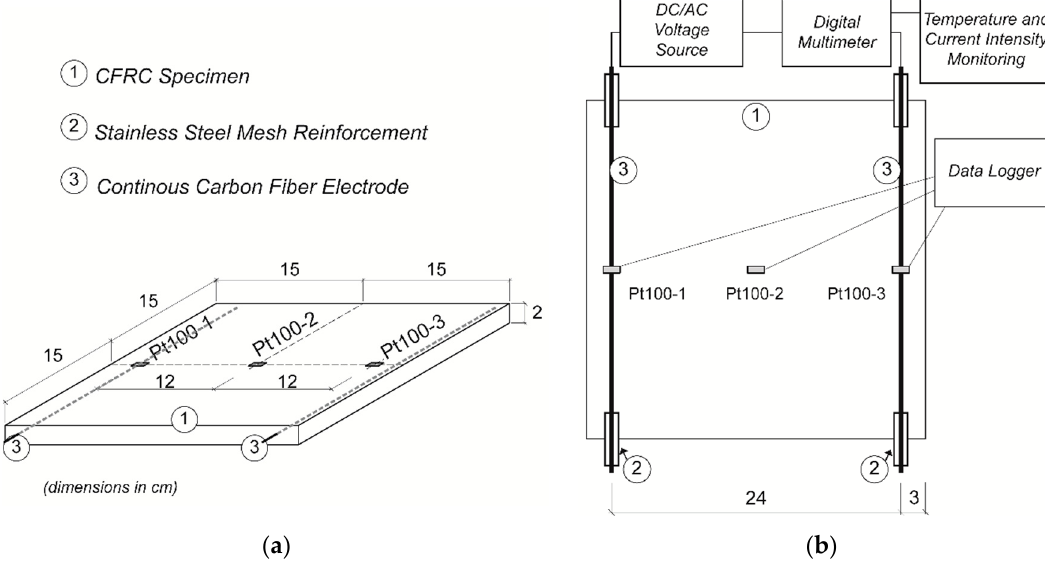
Figure 1. ( a ) Specimen geometry and location of temperature sensors, Pt100; ( b ) Experimental setup for self-heating test.